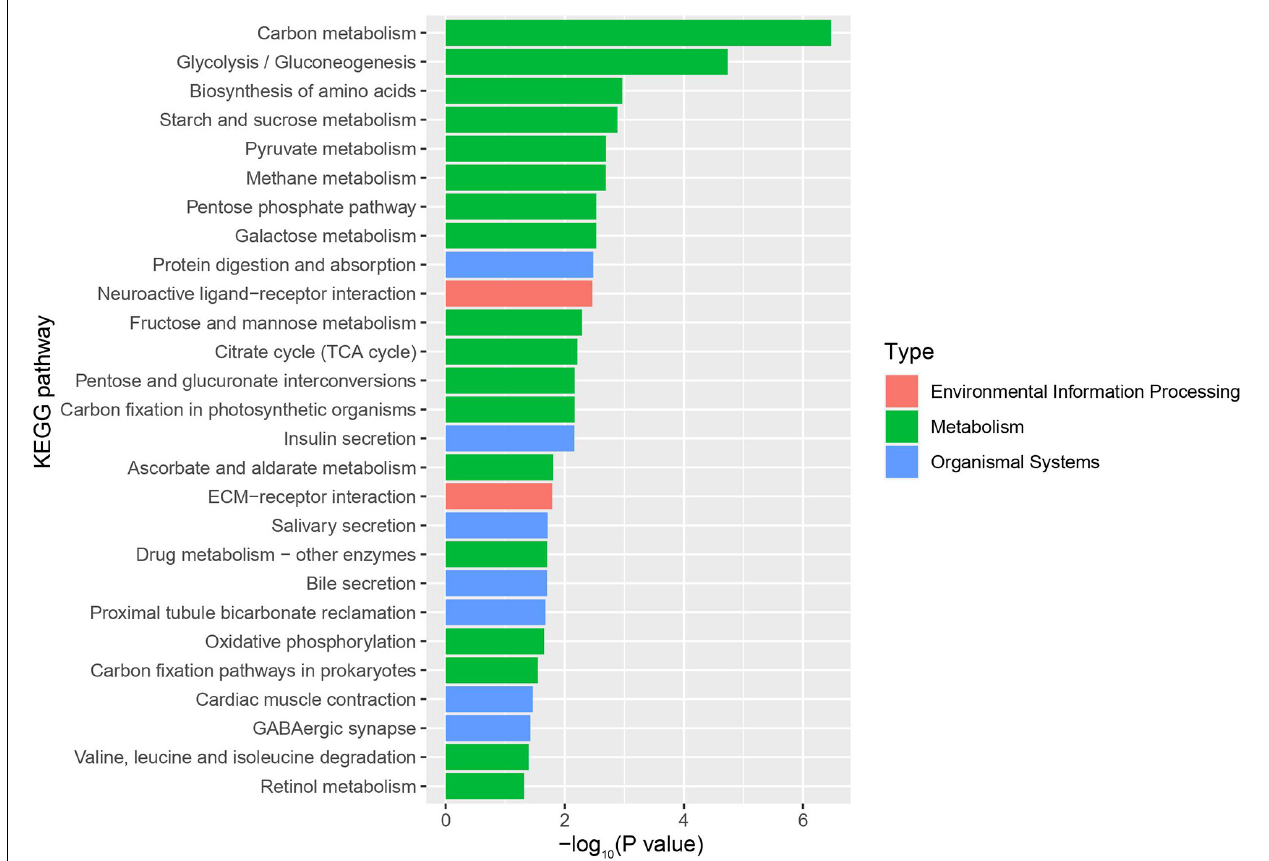
FIGURE 5 | KEGG pathway enrichment plot of differentially expressed genes (DEGs) between the infected group and the healthy group. The x-axis is the negative logarithm of the p -value, and the y-axis is KEGG pathway ( P -value <